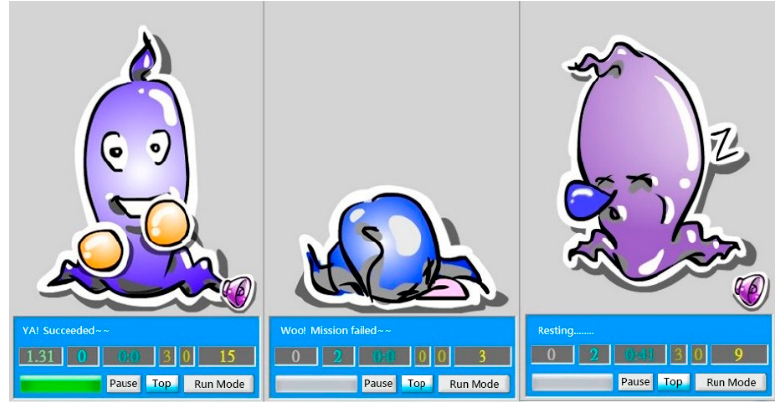
Figure 7. Agent LeLe feedback.